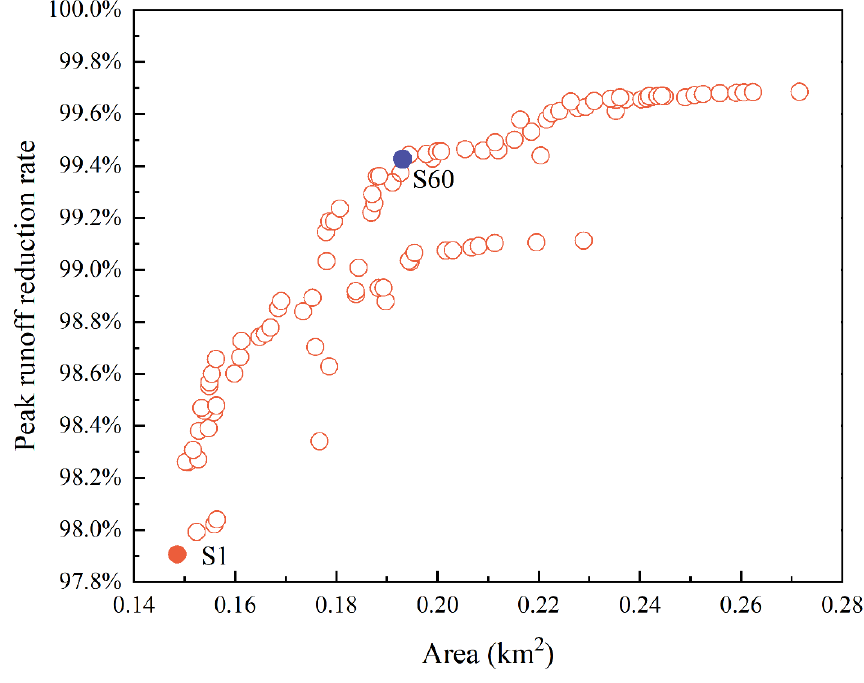
Figure 9. A plot of the peak runoff abatement rate – area relationship. Table 4. Analysis of different optimization options based on peak runoff abatement